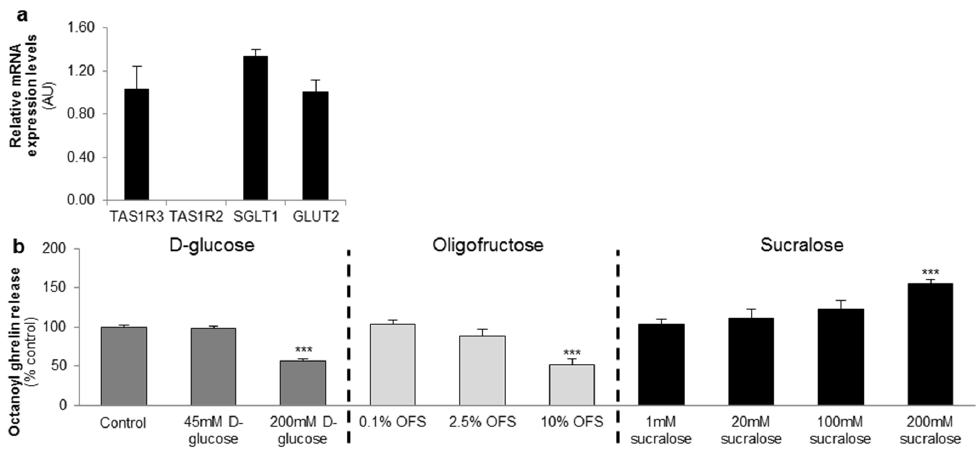
Figure 1. D -glucose and the low-intensity sweetener oligofructose (OFS) decrease octanoyl ghrelin release while a high-intensity sweetener sucralose increases octanoyl ghrelin secretion from a ghrelinoma cell line. ( a ) Relative mRNA expression levels of the two subunits of the sweet taste receptor (TAS1R2-TAS1R3), and the glucose (sodium-dependent glucose cotransporter (SGLT-1), glucose transporter 2 (GLUT2)) transporters in the ghrelinoma cell line, MGN3-1 ( n = 3/sensor); ( b ) Concentration-dependent effect of 3-h stimulation with D -glucose, OFS and sucralose on octanoyl ghrelin release ( n = 9–12). Results (mean ± standard error of the mean (SEM)) are expressed relative to the control stimulation (Krebs buffer containing 11.1 mM D -glucose). *** p < 0.001 vs. control. AU: arbitrary units.